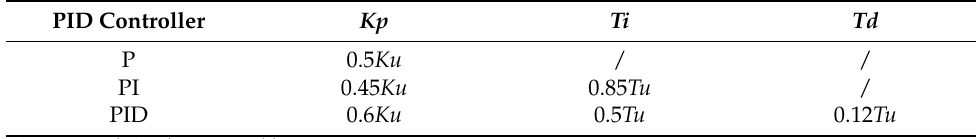
Table 1. ZN Critical Scaling Method Parameter Tuning.